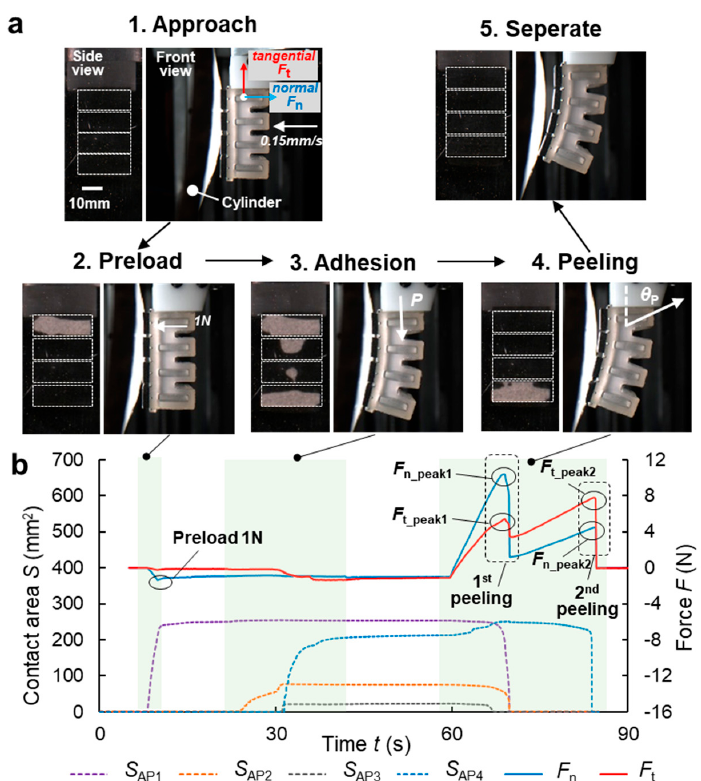
Figure 5. ( a ) The flow of the adhesion-peeling performance test of the SPAA. ( b ) A typical curve of tangential adhesion force ( F t ), normal adhesion force ( F n ) of the SPAA, and contact areas of four APs ( S AP1 ~ S AP4 ) versus the time.